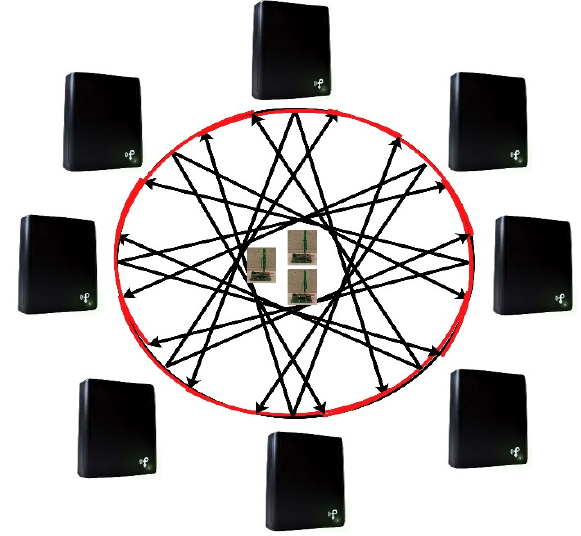
Figure 11. 340° Sense Data from Patch Antenna.